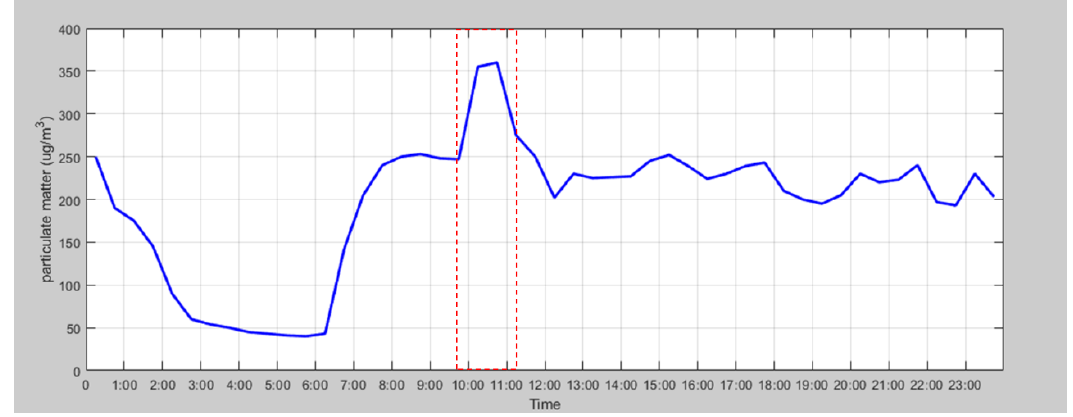
Figure 7. Daily concentration of PM 10 in Bupyeongsamgeori station tunnel.